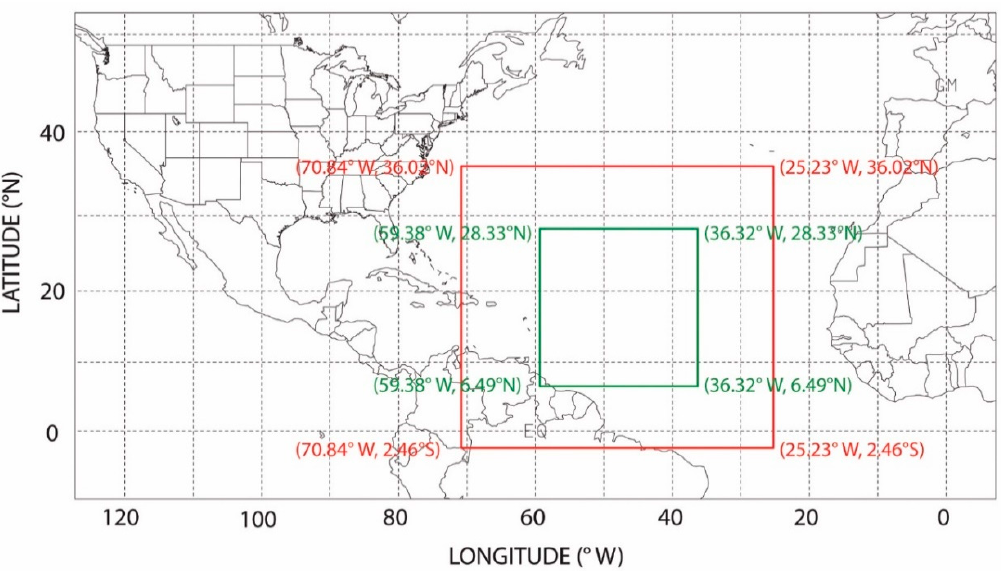
Figure 2. Three domains of the FCDI analysis of Hurricane Irma (2017) at 1200 UTC 3 September. The outer Domain 1 is fixed with 36 km grid spacing, while Domain 2 (red lines) with 12 km grid spacing and Domain 3 (green lines) with 4 km grid spacing move with the storm.